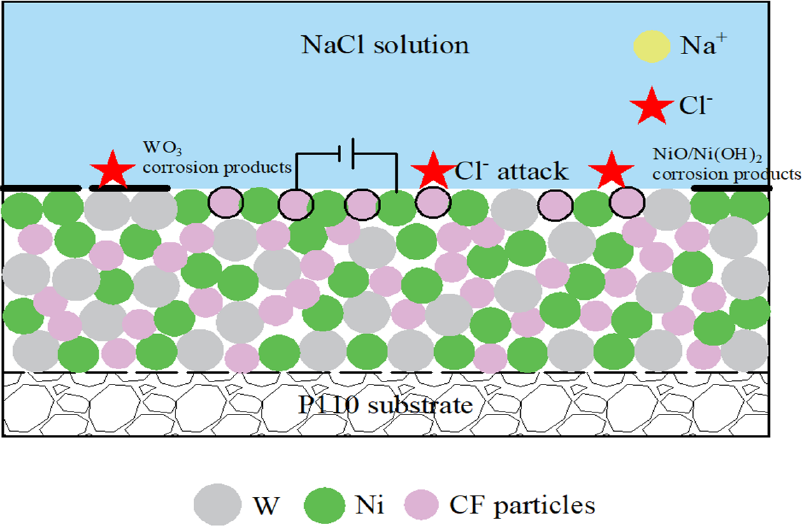
Figure 11. Schematic diagram of corrosion process of Ni-W-CF coating in 3.5% NaCl solution.